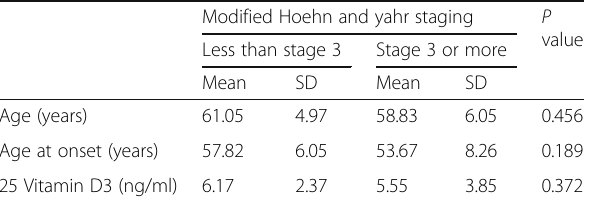
Table 3 Comparison between patients distributed according to modified Hoehn and Yahr regarding clinical parameters